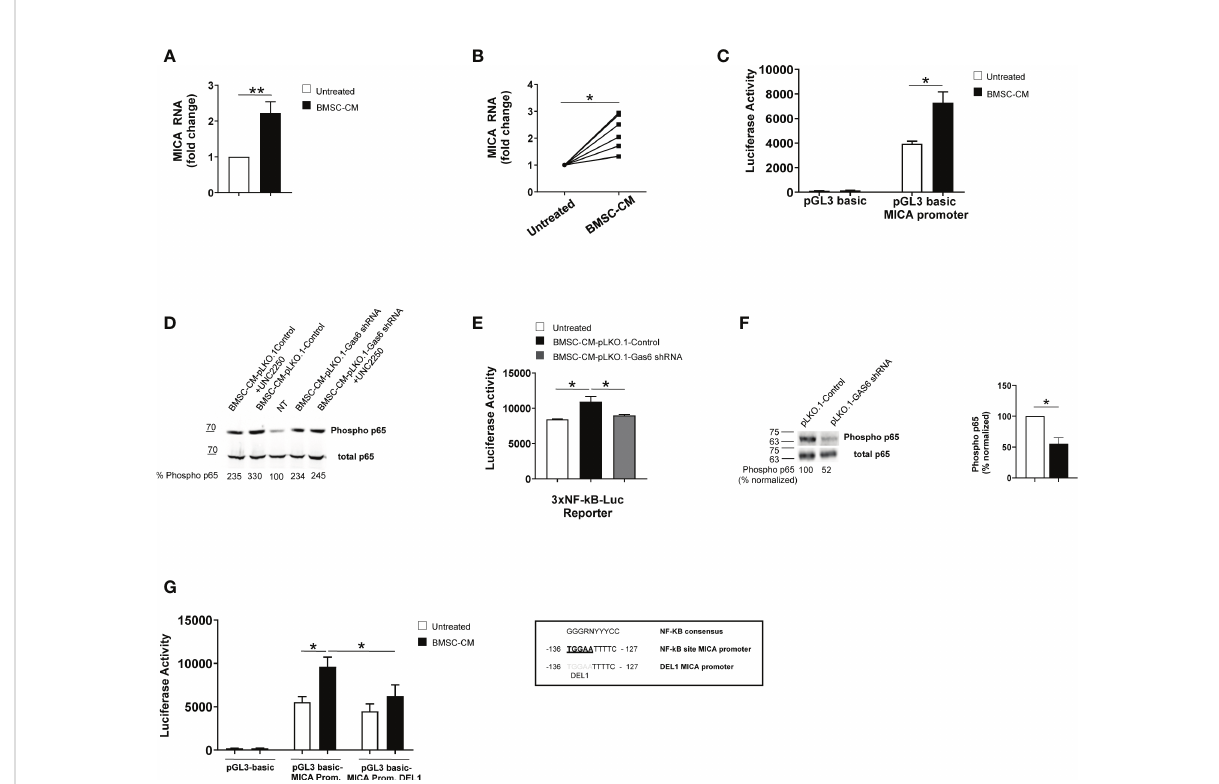
FIGURE 5 BMSC-CM increases MICA mRNA expression and promoter activity via NF-kB activation. Real time PCR analysis of total mRNA obtained from SKO-007(J3) cells (A) or patient-derived PCs (B) after 48h stimulation with BMSC-CM or complete medium. Data, expressed as fold change units, were normalized with GAPDH and referred to the untreated cells, considered as calibrator. For SKO-007(J3) cells, histograms represent the mean ± SD from six independent experiments. For primary PCs, data from 7 MM patients are shown where each dot represents a single patient. (*P< 0.05; ** P <0.005; Mann-Whitney Test). SKO-007(J3) cells were transiently transfected with pGL3 basic empty vector/MICA 270bp promoter plasmid (C) and/or a DEL1-270bp MICA promoter plasmid (in which a putative NF-kB site indicated in the fi gure was removed by site- directed mutagenesis) (G) or infected with lentivirus pHAGE-3xNF-kB-LUC-GFP (E) as described in materials and methods. After 48h of treatment with BMSC-CM, SKO-007(J3) cells were harvested, and protein extracts were prepared for the luciferase assay. Data, expressed as relative luciferase activity, were normalized to protein concentration and renilla activity and represent the mean±± SEM from three independent experiments ( *p < 0.05; ANOVA). Total protein extracts obtained from SKO-007(J3) treated with CM derived from BMSCs pLKO.1-GAS6 shRNA or pLKO.1-Control in the absence or in the presence of UCN2250 (1 µM) (D) or SKO-007(J3) infected with lentivirus pLKO.1-GAS6 shRNA or pLKO.1-Control (F) were analyzed for phosphorylated and total p65 expression by Western Blot. Numbers represent densitometric analysis